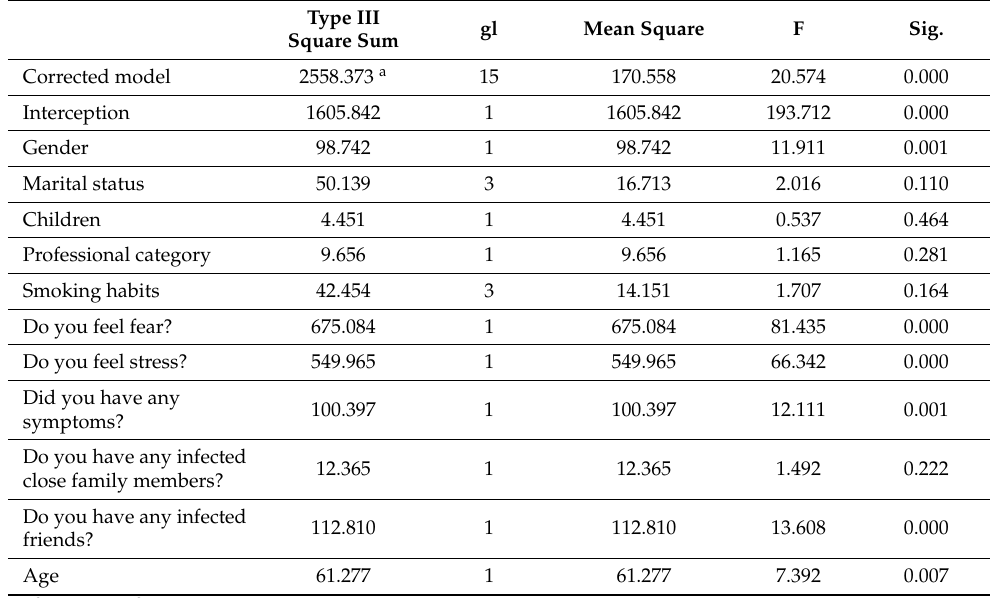
Table 4. Predicting HADS-D